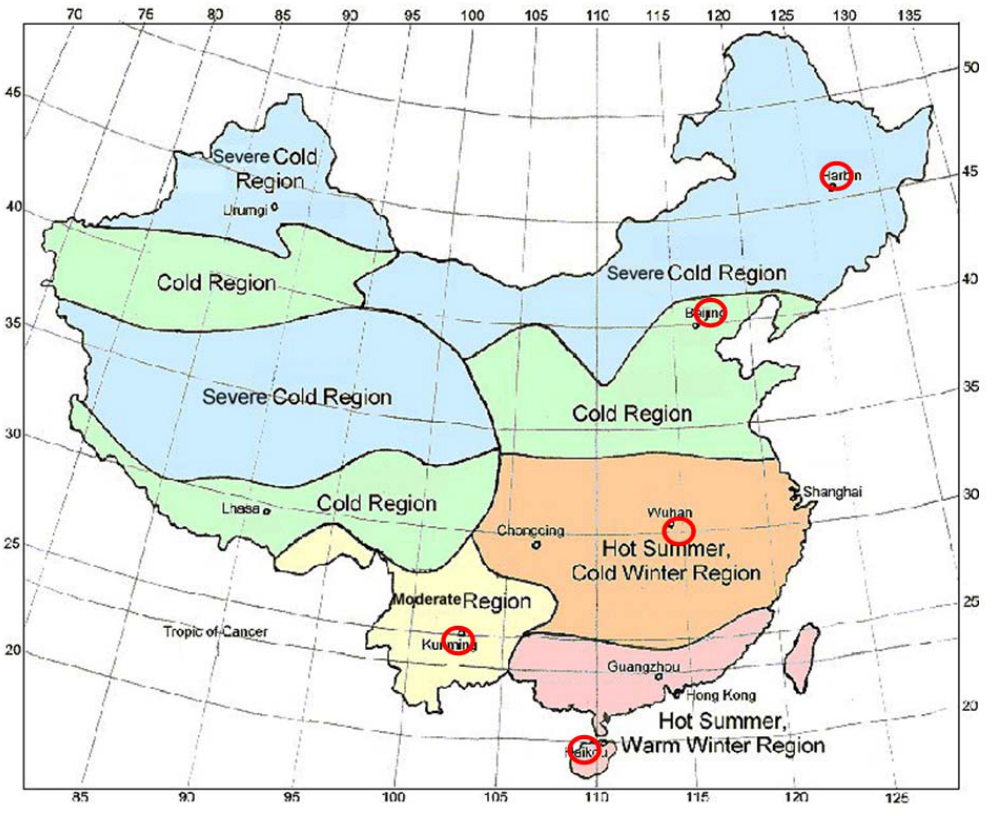
Figure 2. After climate map (Specification for thermal design of civil building GB